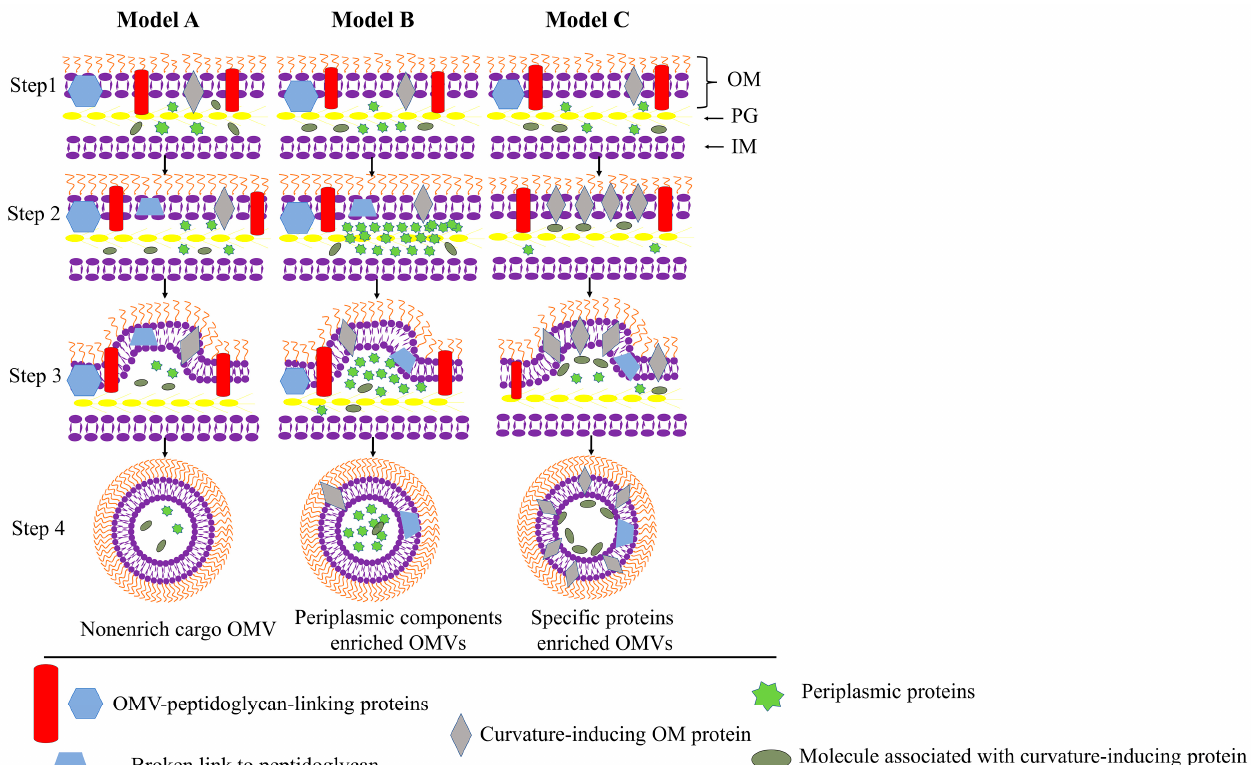
Figure 3. Biogenesis of OMVs via OM blebbing. Step 1: Gram-negative bacterial-cell-enveloped proteins are initially uniformly distributed. The outer membrane is linked with peptidoglycan. Steps 2 and 3: Vesiculation is initiated when the connection between the outer membrane and the peptidoglycan is lost due to the migration of connecting proteins or direct breakage. Models A, B, and C demonstrate three possible mechanisms of OMVs generation. Model A depicts OMV production at its most basic level. In model B, additional budding events can be generated by periplasmic protein aggregation. The resulting OMVs are enriched with periplasm cargo. In model C, the accumulation of curvature-inducing OM proteins causes OMVs to bud from the Gram-negative bacterium at specific proteins on the envelope surface. The OMVs will be enriched with curvature-inducing molecules and molecules associated with them (adapted from [55]). This figure is adapted with copyright